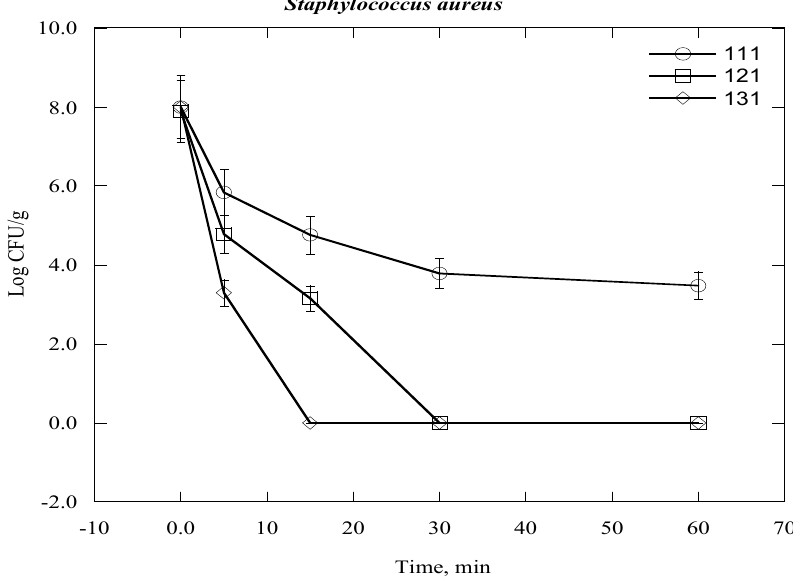
Figure 4. Inactivation of Staphylococcus aureus in clinical solid waste using steam sterilization. Experimental conditions: (○), 111 °C (8 psi); (□), 121 °C (15 psi) and (◊), 131 °C (27